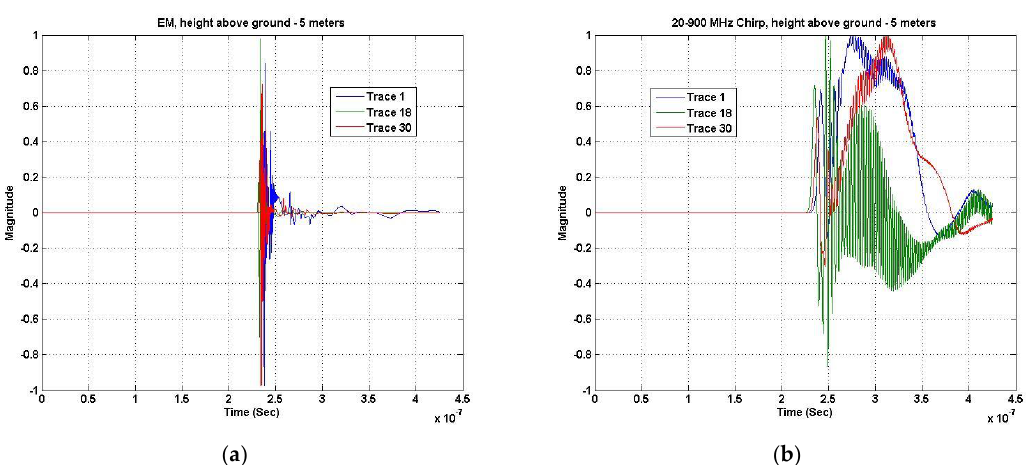
Figure 6. ( a ) Traces 1, 18, and 30; plots of EM GMM analysis. ( b ) Traces 1, 18 and 30; plots of chirp excitation analysis.